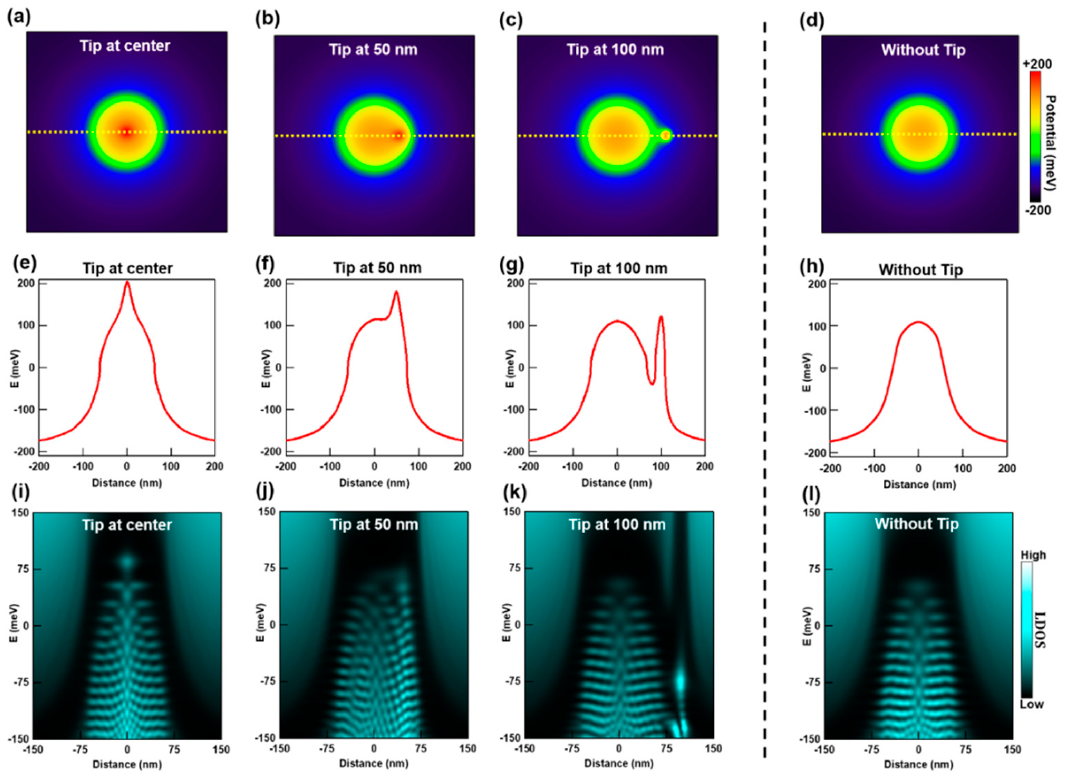
Figure 5. Simulation of the local density of states (LDOS) of an exposed graphene QD with an STM tip at a fixed position. ( a – c ) Spatial 2D map of graphene’s Dirac point energy with respect to E F after adding the contributions from hBN defects (Figure 3c) and the STM tip (Figure 4b). The STM tip’s location varies for each of these maps. ( d ) Spatial 2D map of the graphene Dirac point energy with respect to (cid:1831) (cid:3007) determined by only considering the contribution from hBN defects (Figure 3c). ( e – h ) Respective potential profile line cuts along the yellow dashed lines in ( a – d ). ( i – l ) Calculated LDOS distributions for each corresponding potential map. These simulations reveal the effect of the STM tip on the QD states for tip positions placed at different distances from the QD’s center.